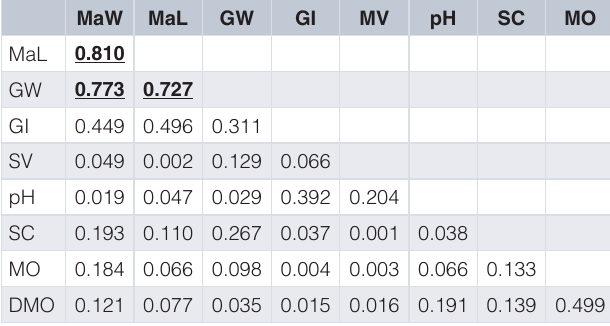
Table 4. Correlations of variables ( r 2 ) for Hemibagrus wyckii males.